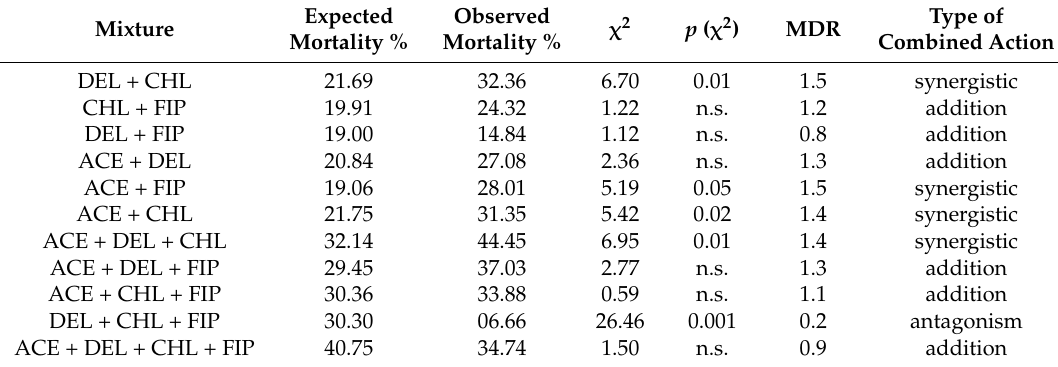
Table 2. Quantitative estimation between predicted and measured toxicity after 24 h, using chi 2 -test and model deviation ratio (MDR); for each mixture, the deduced type of combined action is reported. Expected Observed Mixture Mortality % Mortality